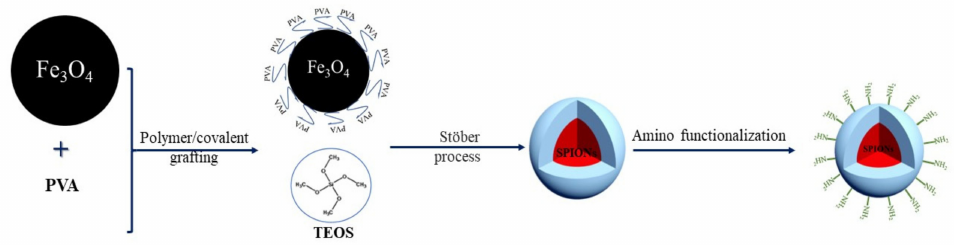
Figure 3. Graphical representation of a surface functionalization